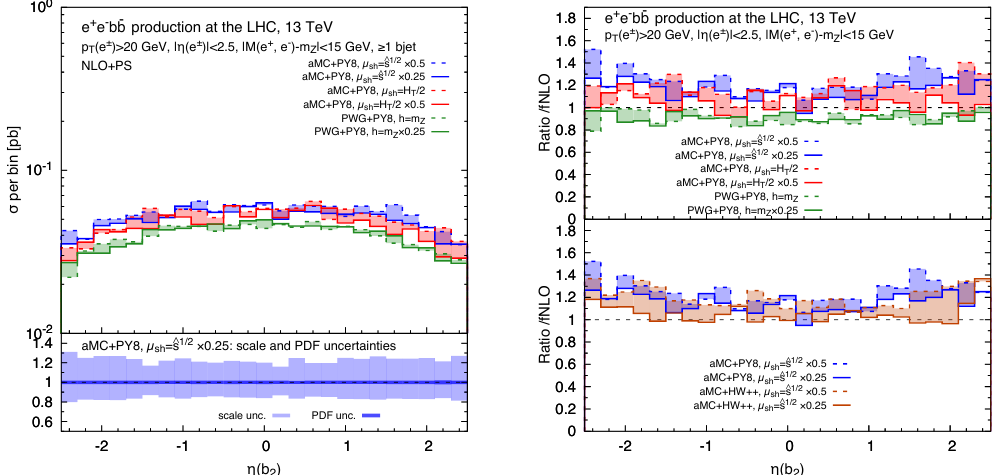
Figure 30 . Pseudo-rapidity distribution of the second-hardest b